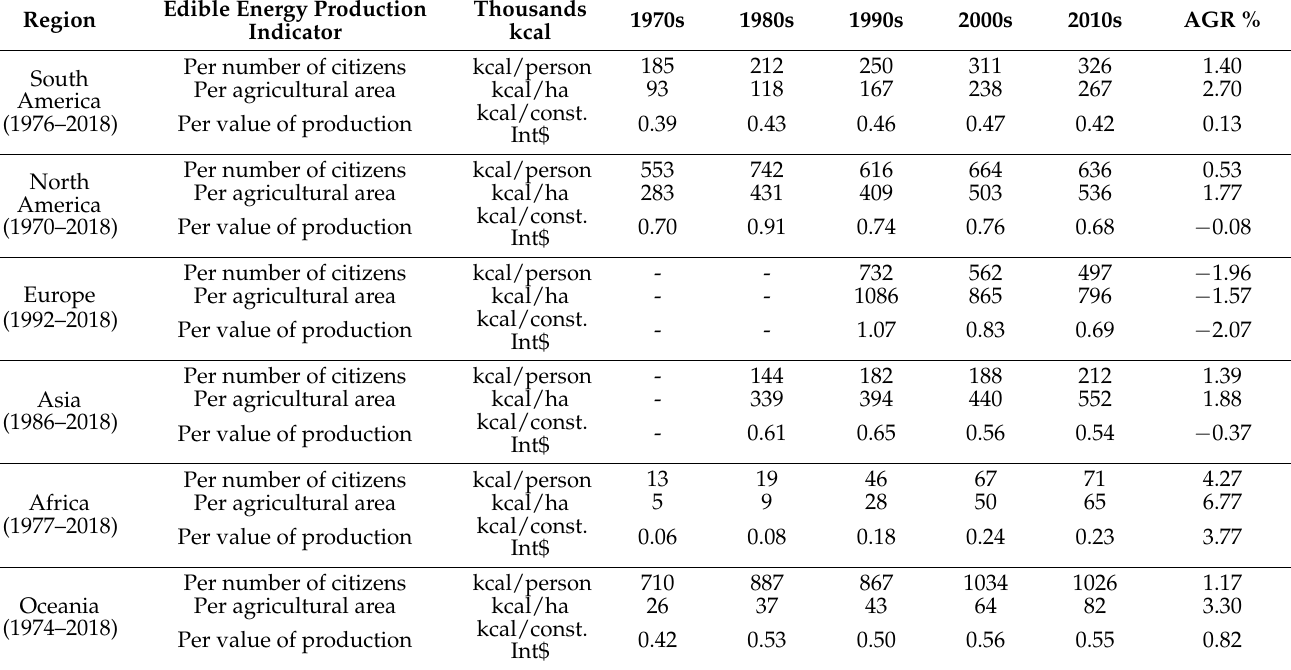
Table 4. Direct energy consumption in agriculture for years